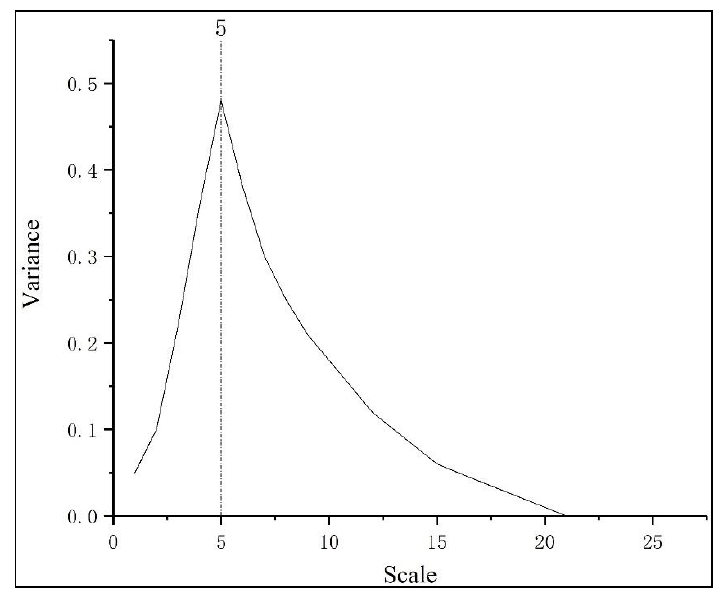
Figure 9. Variance curves of wavelet transform coefficients at different scales.